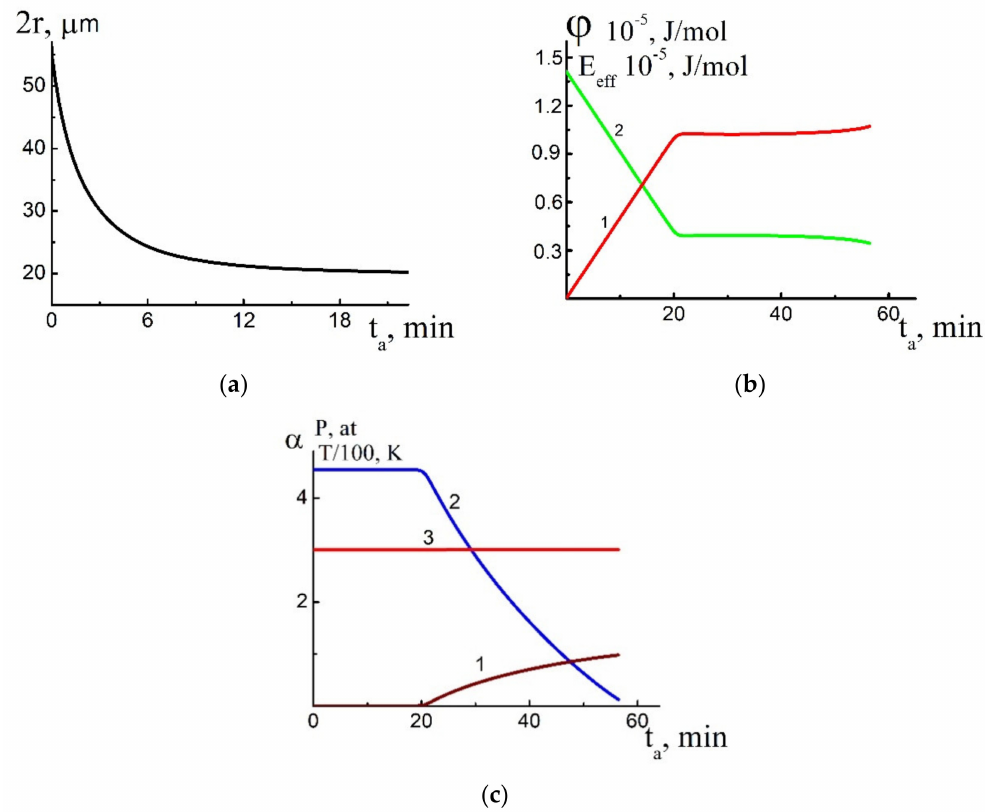
Figure 5. ( a ) Theoretical dependencies of particle size, ( b ) excess energy (curve 1), activation energy (curve 2), ( c ) depth of chemical transformations (curve 1), nitrogen pressure in the chamber (curve 2), and temperature of the system (curve 3) for grinding of titanium powder in nitrogen for m ∑ ,0 =